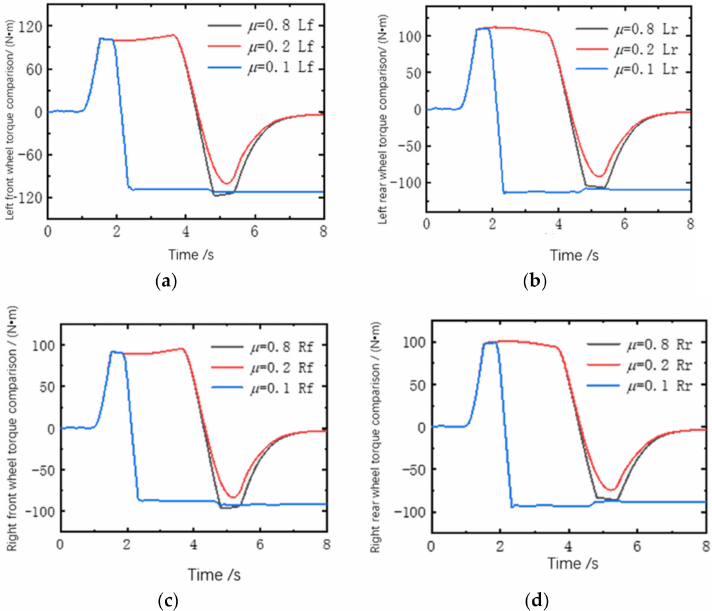
Figure 10. Comparison of torque distribution among wheels. ( a ) Torque comparison of left front wheel. ( b ) Torque comparison of left rear wheel. ( c ) Torque comparison of right front wheel. ( d ) Torque comparison of right rear